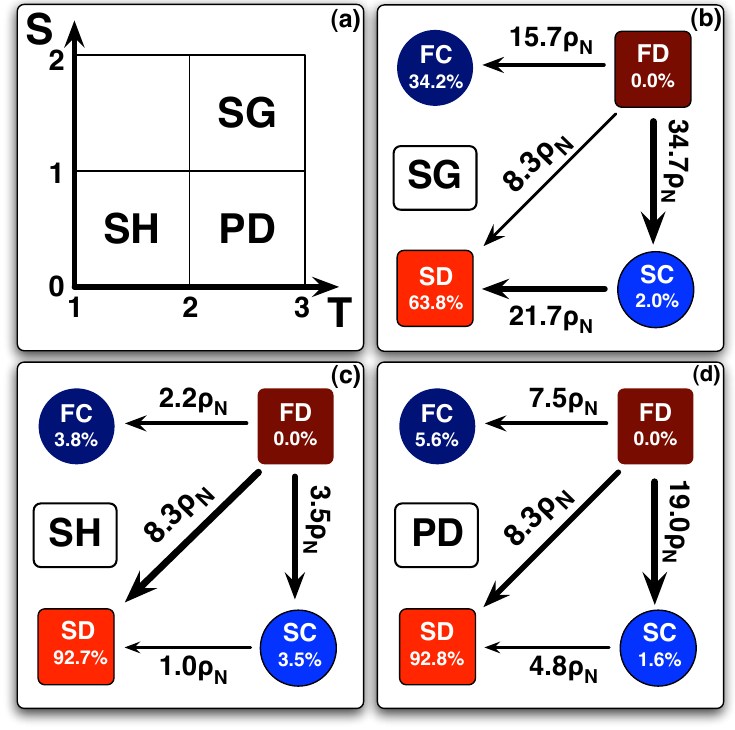
Figure 9. Transition probabilities and stationary distributions for the stag-hunt and snowdrift games. (a) Two-dimensional parameter space defining all three social dilemmas. By fixing R = 2 and P = 1 , while 0 ≤ S ≤ 1 and 1 ≤ T ≤ 3 , we can represent the three most popular social dilemmas of cooperation: The PD ( S < 1 and T > 2 ), the SG ( S > 1 and T > 2 ) and the SH ( S < 1 and T < 2 ). (b), (c) and (d) Transition probabilities and stationary distributions for the three dilemmas with two types of individuals. The dynamics is reduced to transitions between homogeneous states of the population. The arrows in black indicate those transitions for which the fixation probability ρ is greater than neutral fixation = 1 ). The explicit values are calculated using the pairwise comparison rule with ( ρ N N parameters N = 100 , β = 0 . 01 , c = 0 . 16 and δ = 0 . 3 . The examples shown were obtained for T = 2 . 1 , S = 0 . 9 (PD), T = 2 . 65 , S = 1 . 35 (SG) and T = 1 . 65 , S = 0 . 35